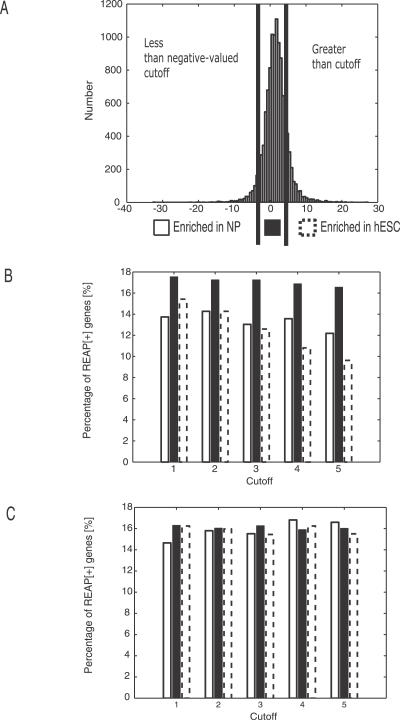
Analysis of REAP[+] Genes Relative to Transcriptional Differences(A) Histogam of t-statistics computed from gene-level signal estimates measuring the enrichment of genes in hESC and in NP. Genes on the right of the vertical line at 5 were designated enriched in hESC and genes on the left of the vertical line at −5 were designated enriched in NP; genes in between −5 and 5 were designated as “unchanged” or expressed similarly in hESC and NP.(B) Vertical bars representing the percentage of REAP[+] genes out of all genes in the different classifications (dashed bar: “enriched in hESC”; black filled bar: “unchanged”; white filled bar: “enriched in NP”), at different cutoffs of 1 to 5.(C) Set of genes where REAP[+] designation was randomly chosen. Similar representation as in (B).